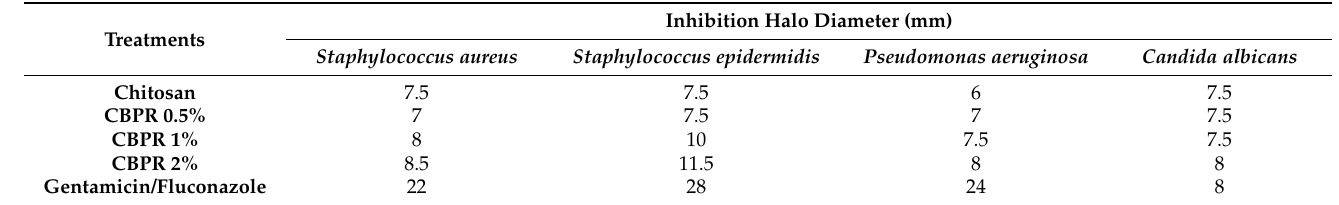
Table 1. Antimicrobial activity evaluated by Kirby–Bauer assay. The diameter of the inhibition zone reported is the mean of three measures of three independent experiments.